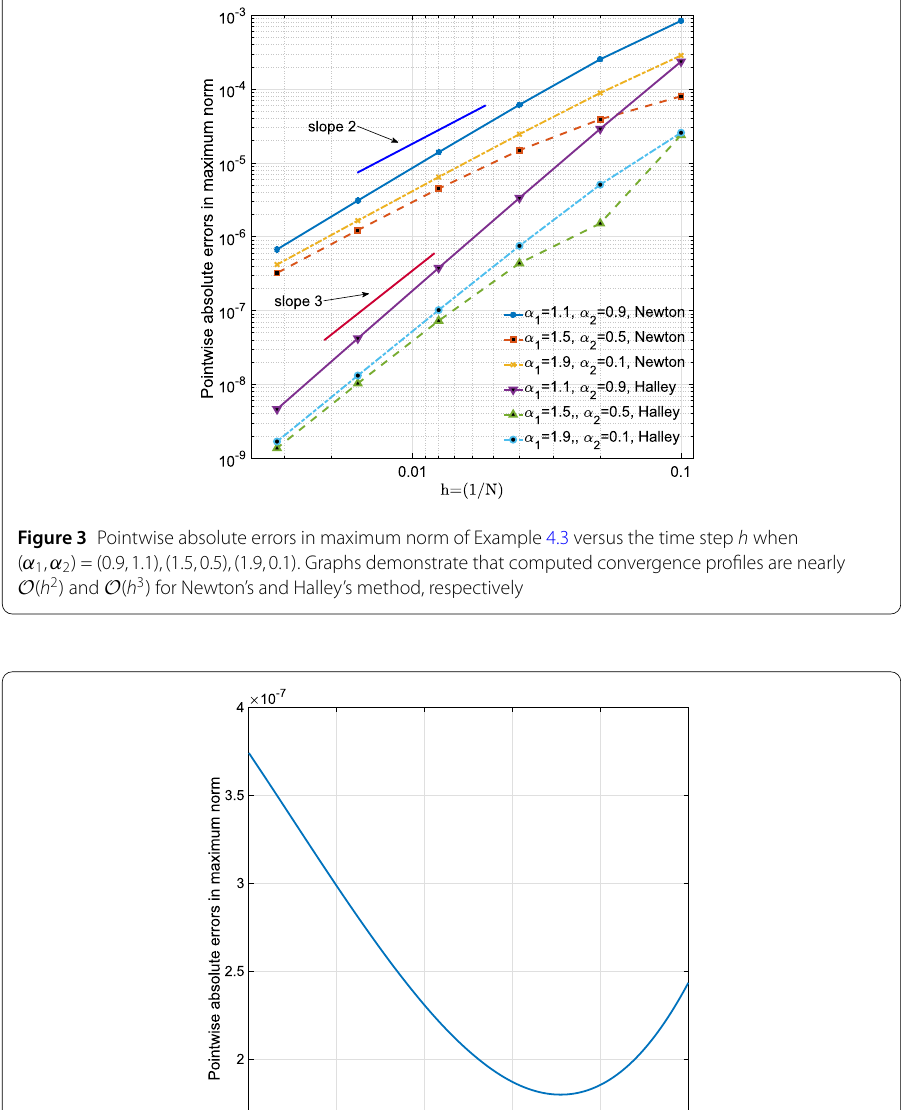
Figure 6 illustrates convergence profiles obtained by the proposed methods and the modified integral discretization scheme [21] with the variety of fractional orders. From the graphs, we can see that computed rates of convergence are nearly O ( h 2 ) for the pro- posed shooting method with Newton’s technique and the modified integral discretization scheme [21], O ( h 3 ) for the proposed shooting method with Halley’s scheme, respectively. Plots exhibited in Figs. 7, 8, 9 display pointwise absolute errors in maximum norm ver- sus the time step h and the approximate solution is computed by the modified integral discretization scheme [21] (in Fig. 7), the proposed shooting technique with